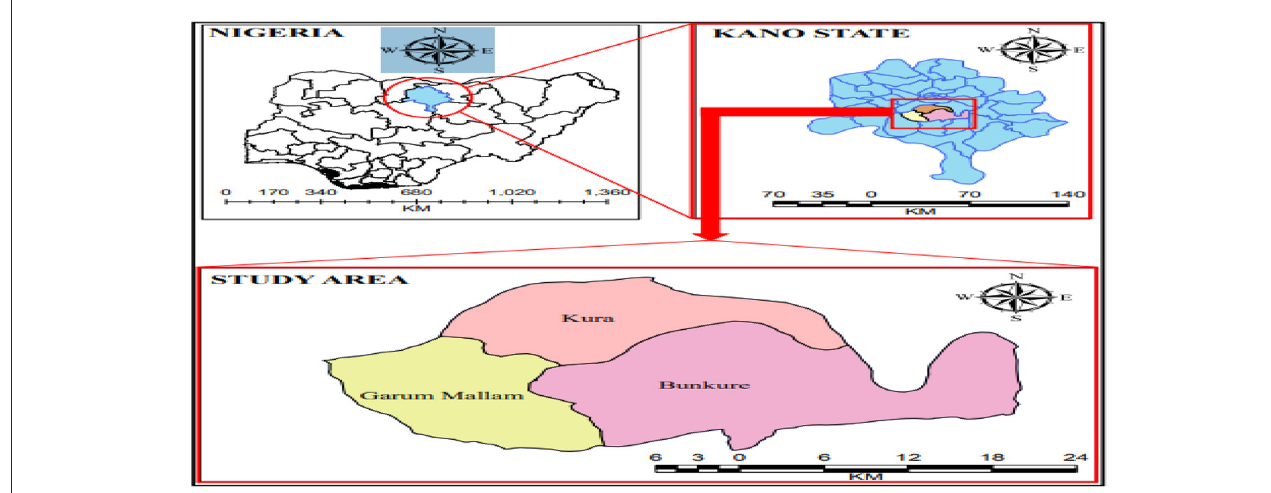
FIGURE1 Map of the study area. Source: Authors’ computation, 2020.